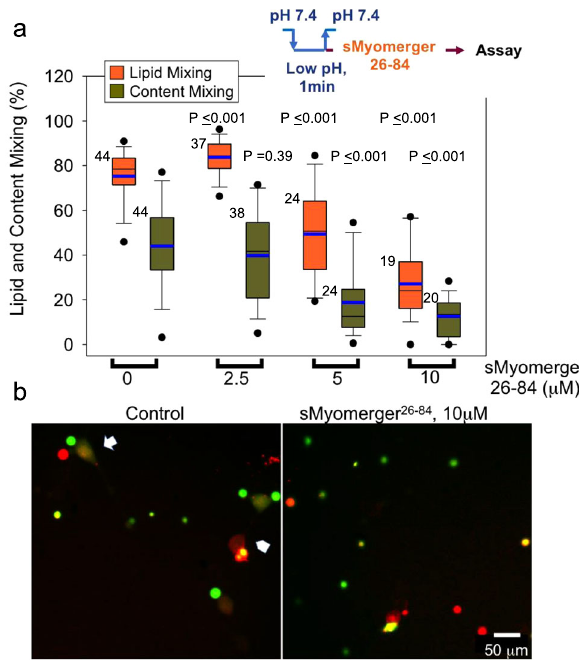
Fig. 5 High concentrations of sMyomerger 26-84 inhibit HA-mediated hemifusion and fusion. a Hemagglutinin (HA)-cells with pre-bound RBCs were treated with a 1-min pulse of pH 5.0 medium at the room temperature. Immediately after the end of low pH pulse, we applied PBS supplemented with different concentrations of sMyomerger 26-84 at the room temperature. Fusion (redistribution of lipid and content probes from RBCs to HA-cells) was analyzed with fl uorescence microscopy. Content mixing (fusion) and lipid mixing (fusion plus hemifusion) were quanti fi ed as the ratios of the numbers of either content probe (carboxy fl uorescein)- labeled HA-cells or lipid probe (PKH26)-labeled HA-cells, respectively, to the total number of HA-cells. N , the number of randomly chosen fi elds of view examined for each condition in one representative experiment out of three independent cell preparations, is indicated to the left of the box associated with that data. Box-and-whisker plots show median (center line), mean (blue line), 25 – 75th percentiles (box), 10 – 90th percentiles (whiskers), and 5 – 95th percentiles (solid circles). P -values were calculated using a two-tailed unpaired t -test. b Representative images for the experiments in a taken for the control cells and for the cells treated with 10 μ M sMyomerger 26-84 . Arrow and arrowhead mark examples of fusion and hemifusion, respectively. Scale bar 50 μ